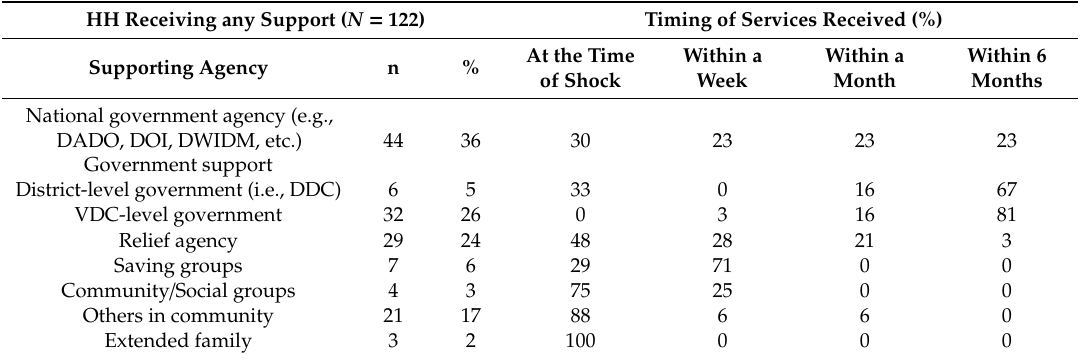
Table 6. Support services and timing of services received by households from di ff erent